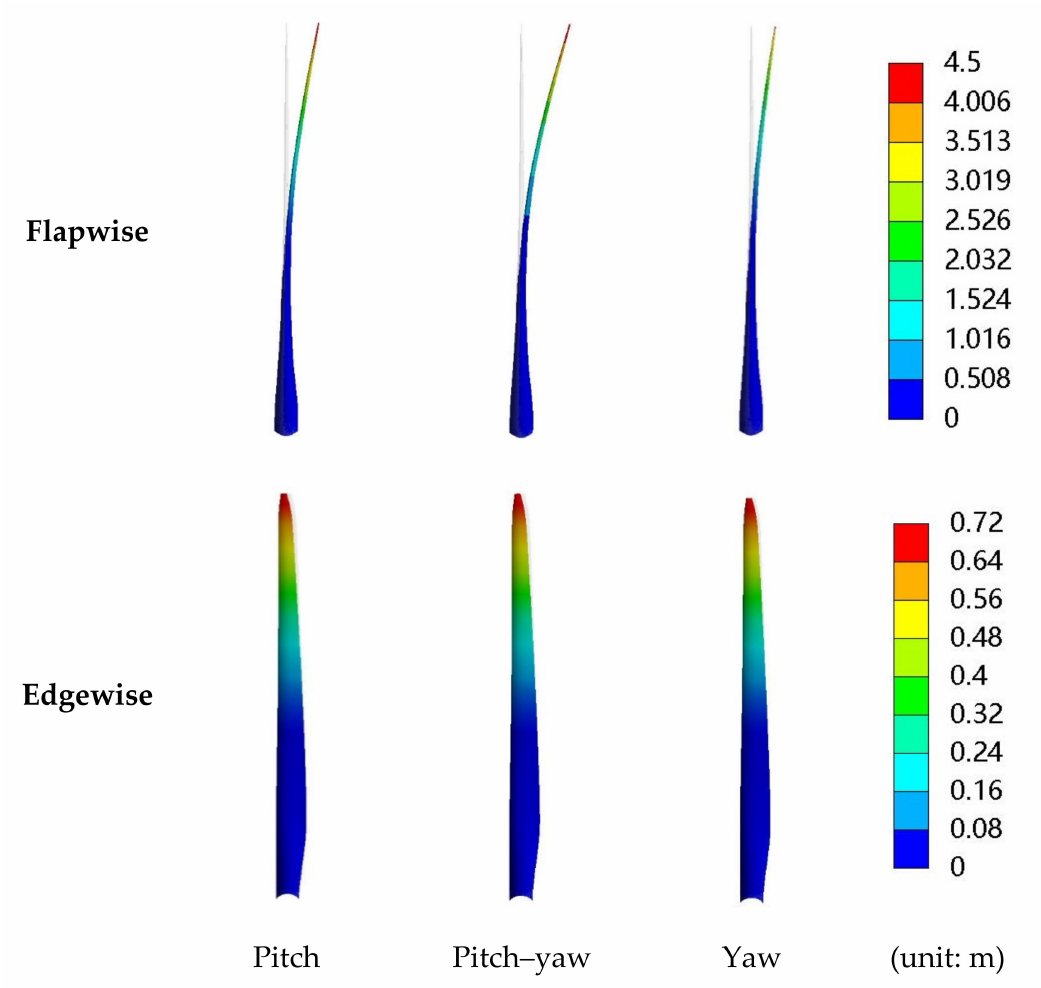
Figure 22. Blade deflection under the forward motion. When the rotor moved backward, the blade deformations were as shown in Figure 23. The deformations of the blade tip in the z -direction and x -direction under the pitch motion were 0.515 m and 0.045 m, respectively. Under the coupled motion, the deformations of the blade tip in the z -direction and x -direction were 0.674 m and 0.069 m, respectively. Finally, under the yaw motion, the deformations of the blade tip in the z -direction and x -direction were 0.927 m and 0.129 m, respectively. Therefore, backward moving caused smaller blade deformation than forward moving. The reason was that the induced-velocity was opposite to the incoming velocity in the chordwise direction, which made the deformation decreasing with the chordwise